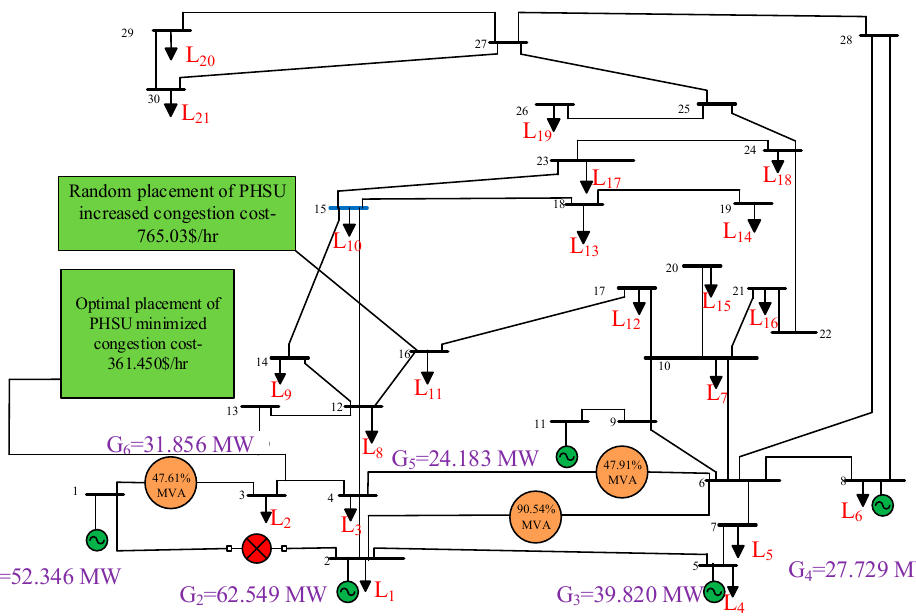
Figure 13. FPA-based cost comparison in placement of PHSU for managing congestion. Table 11. FPA-based MVA line flow with and without